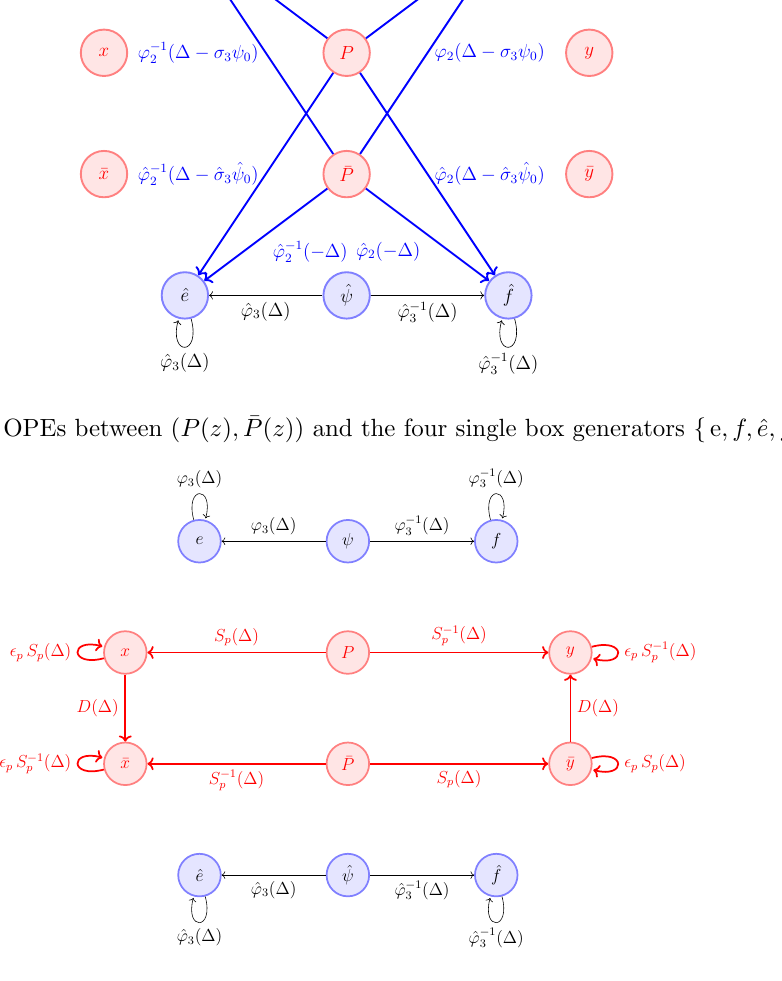
Figure 8 . OPEs among gluing